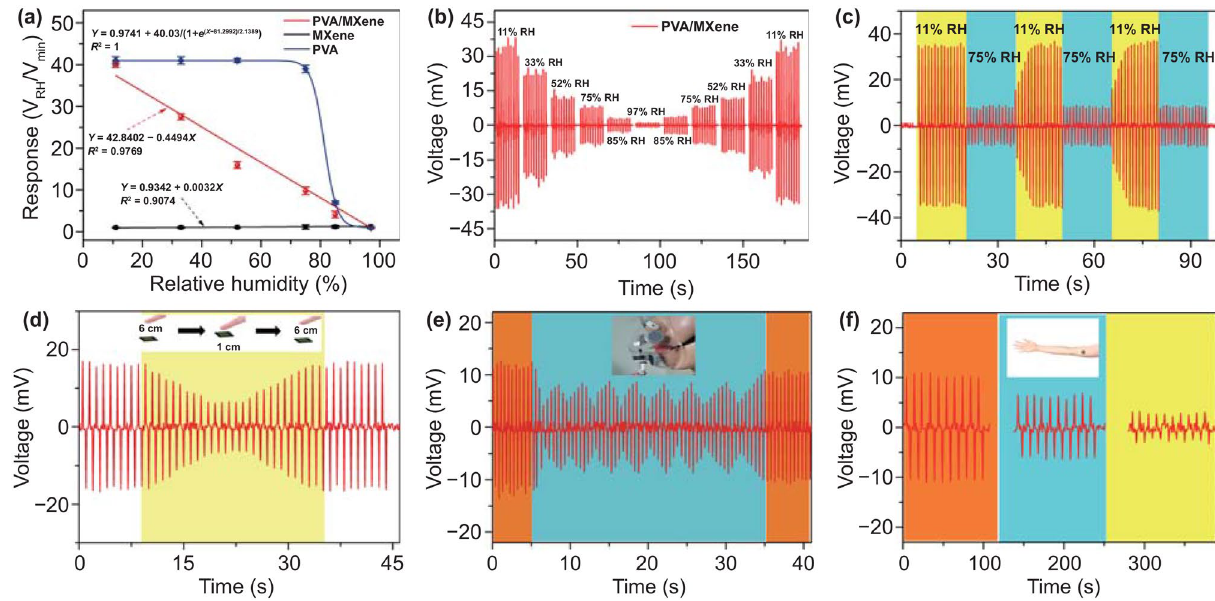
Fig. 6 a Response fitting curves of self-powered MXene, PVA, and PVA/MXene film sensors toward different humidities. b Output voltage for PVA/MXene-based PEHS upon exposure to different humidities. c Repeatability of self-powered PVA/MXene sensor. d Output voltage when the finger slowly approaches the sensor. e Flexible sensor is used to detect human breathing rate. f Test result of detecting the humidity of arm skin surface after different exercise